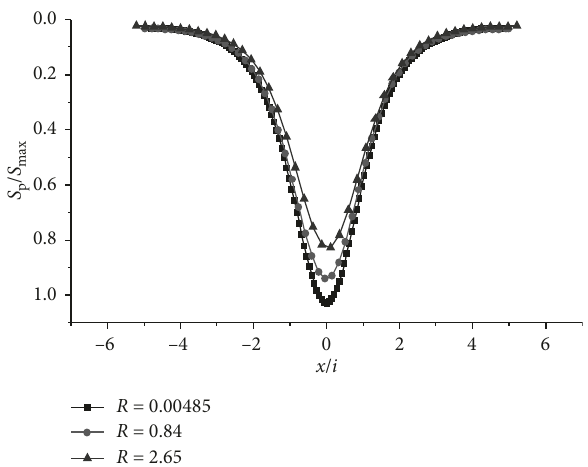
Figure 8: Numerical calculation of subsidence chart about the surface and